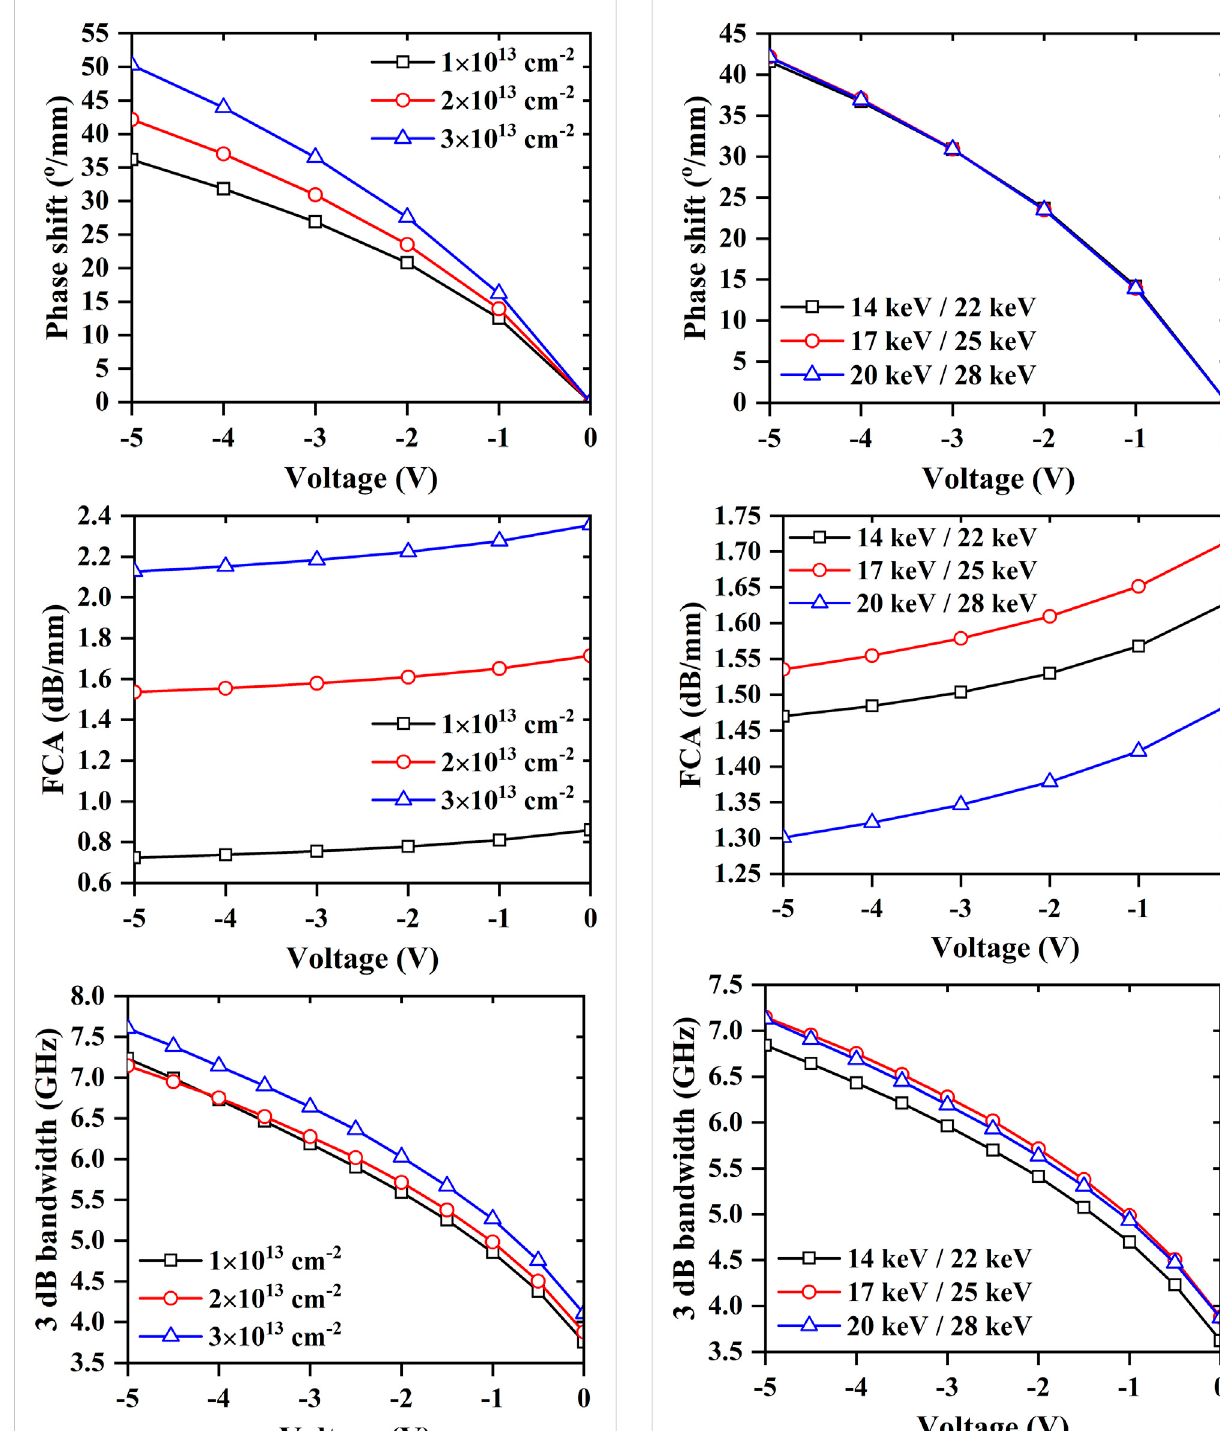
FIGURE 4 (A) Phase shift per unit length, (B) free-carrier absorption per unit length, and (C) 3-dB bandwidth for different boron/phosphorus implantation